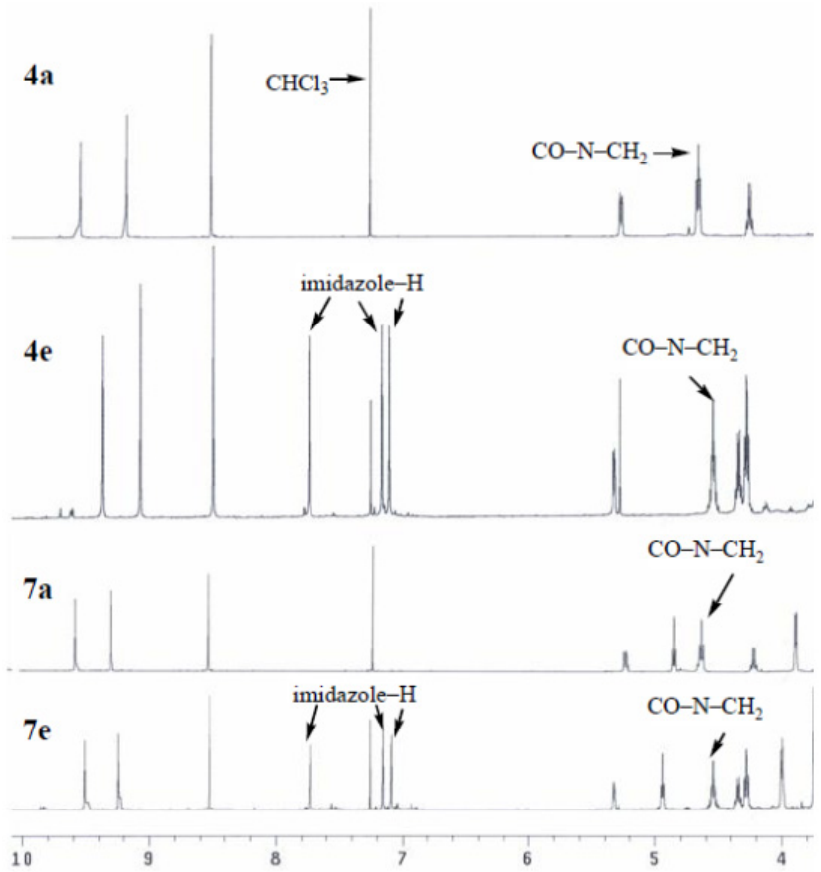
Figure 1. The comparative 1 H NMR spectra (CDCl of purpurinimides 4a , 4e , 7a and 7e